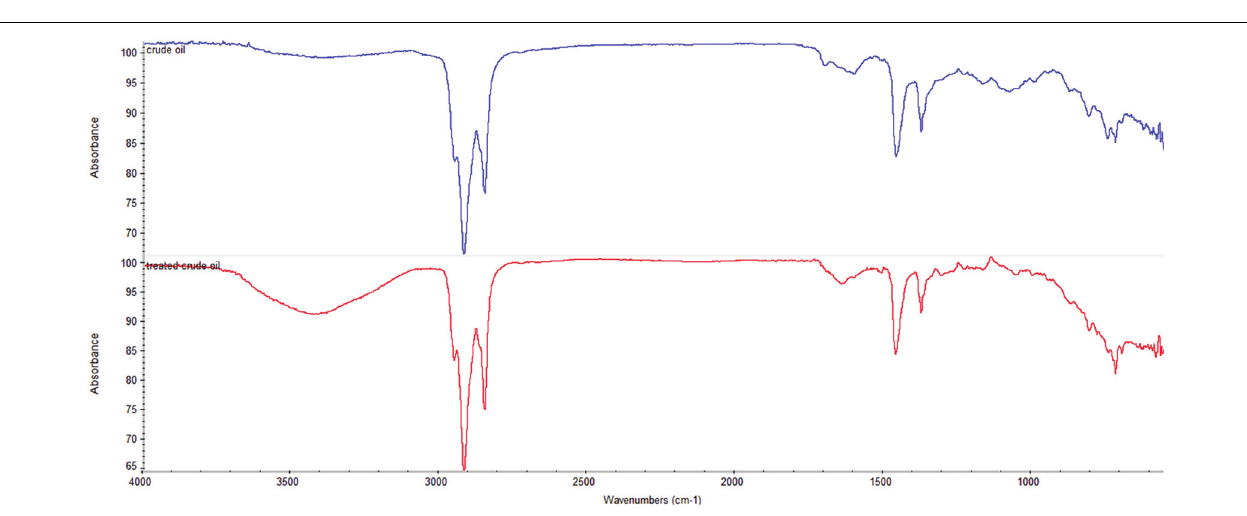
FIGURE 6 | Fourier transform infrared spectra of the DCM extracted portion of untreated control crude oil (—) and the crude oil treated with consortium 10 for 5 weeks